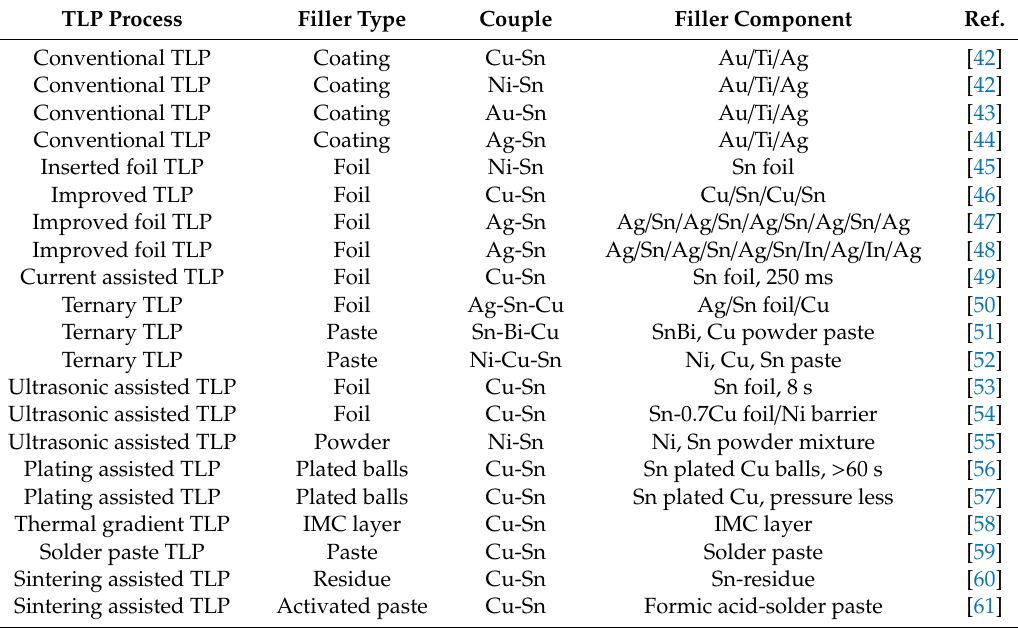
Table 1. Various joining methods used in TLP bonding and Sn-based systems. TLP